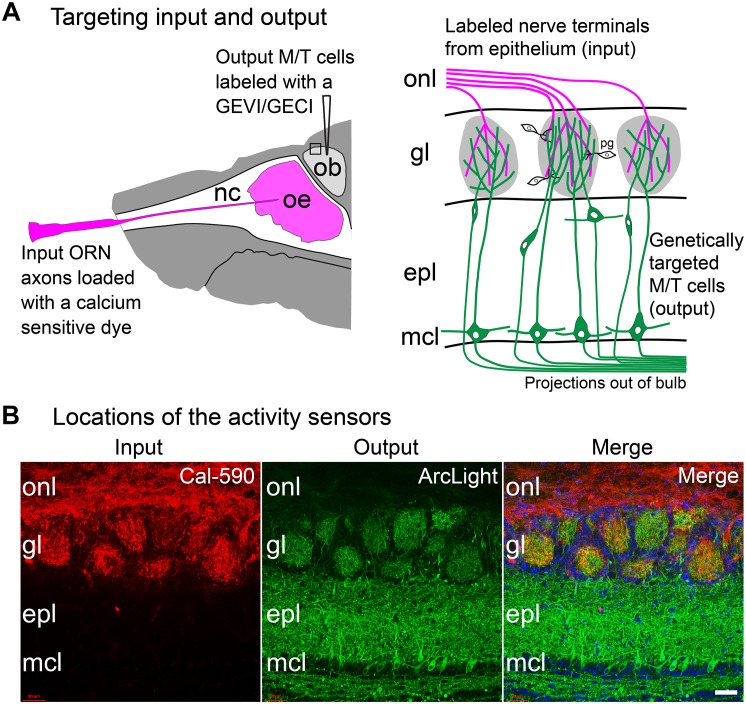
Approach to measure both the input and output of the same glomeruli in the mouse olfactory bulb. (A) Experimental approach: Left, the olfactory receptor neuron nerve terminal input is labeled via nasal infusion of an organic calcium sensitive dextran dye together with a low concentration of Triton-X. In the same preparation, GEVIs or GECIs were targeted to mitral and tufted output cells using cre-dependent AAVs in a transgenic mouse that expressed cre recombinase in those cells. Right, input and output can be measured independently from the same glomerulus by using activity sensors with substantially different excitation or emission spectra. The signals from the two cell types can be distinguished by changing the excitation or emission wavelengths. (B) A doubled labeled histological section showing targeting to input vs. output. In this section, Cal-590 dextran was anatomically targeted to the olfactory receptor nerve terminal input (left) and ArcLight was genetically targeted via AAV injection to the mitral and tufted cell output (middle). The merged image is shown on the right. Both sensors are present in each glomerulus. onl, olfactory nerve layer; gl, glomerular layer; epl, external plexiform layer; mcl, mitral cell layer. Scale bar in panel (B), 50 μm. Modified from Storace and Cohen (2017).